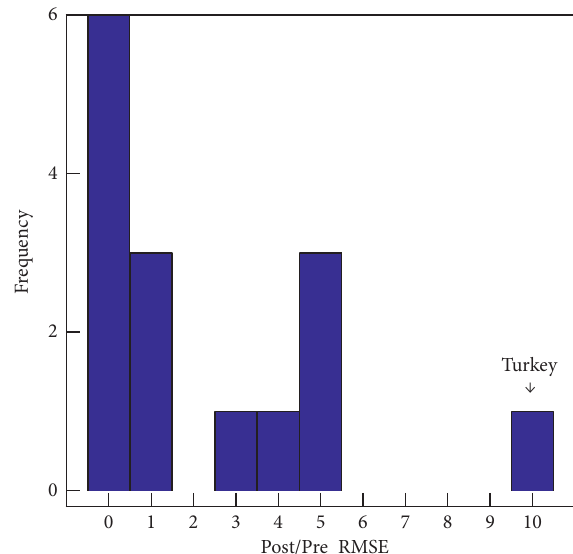
Figure 8: Ranking test of policy effect of Turkey’s higher education development